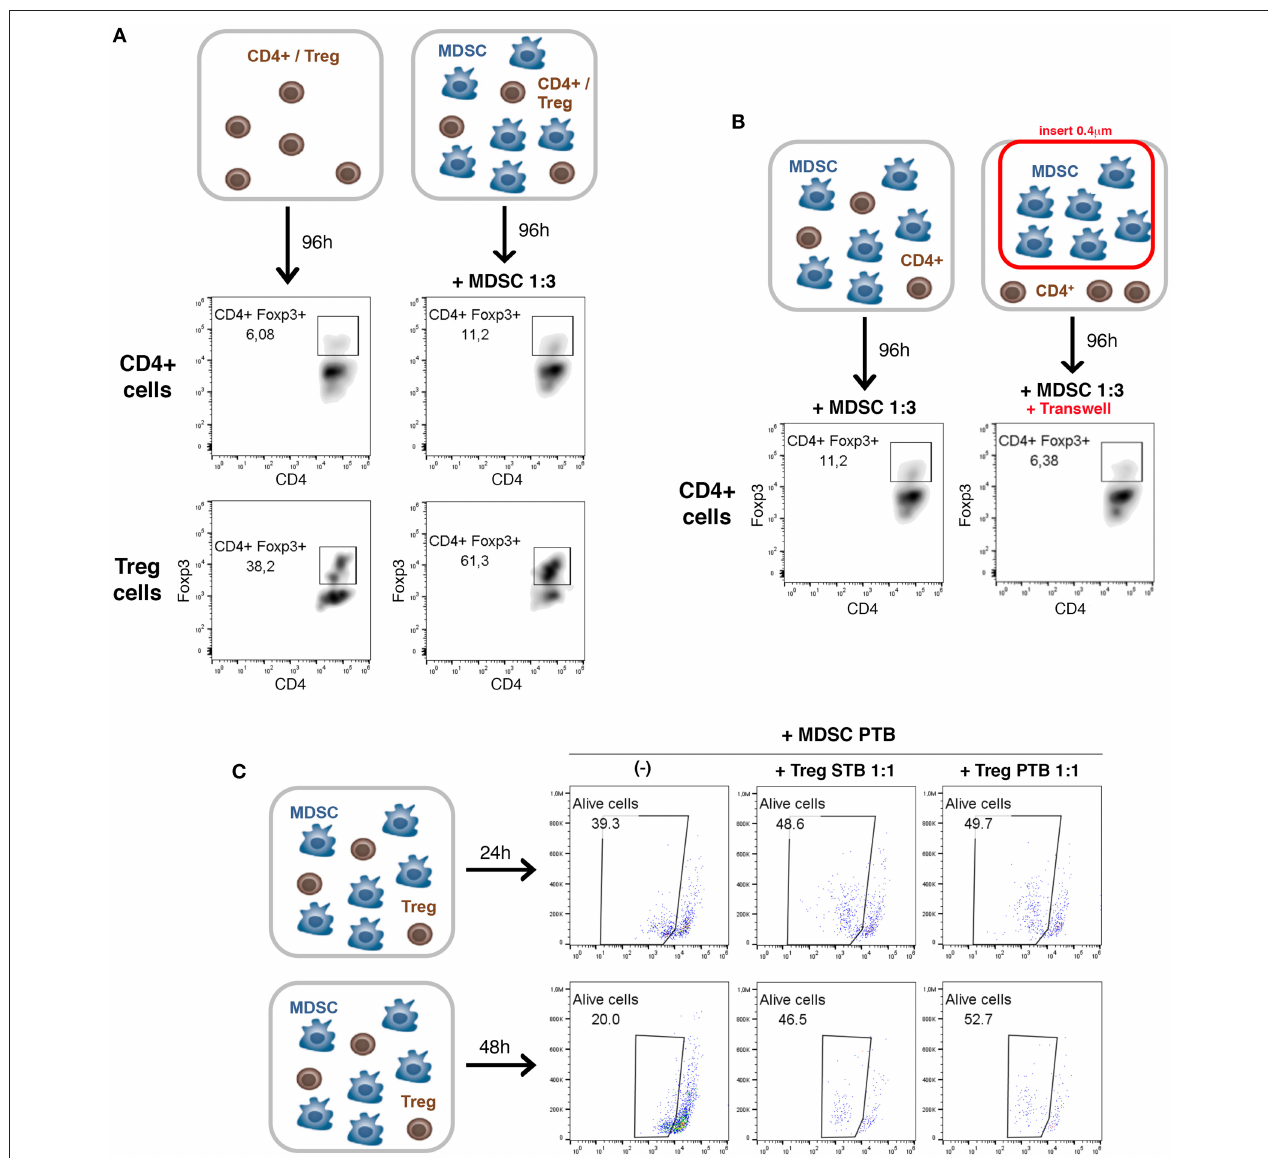
FIGURE 5 | A cell-cell dependent crosstalk between tumoral MDSCs and Treg cells. (A) Purified CD4 + T cells or Treg cells (CD4 + CD25 + ) from TB mice were cocultured with tumoral MDSCs. The percentage of CD4 + Foxp3 + cells was evaluated by flow cytometry after 4 days of culture in the presence of CD3/CD28 stimulation. (B) Purified CD4 + T cells from TB mice were cocultured with tumoral MDSCs at 1:3 ratio in conventional dishes or using Transwell chamber to separate the 2 cell populations. The percentage of CD4 + Foxp3 + cells was evaluated after 4 days by flow cytometry. (C) Purified Treg cells (CD4 + CD25 + ) from spleen of tumor-bearing mice (Treg STB) or tumor (Treg PTB) were cocultured with tumoral MDSCs for 24 or 48h. The viability of MDSCs was then assessed by flow cytometry using LIVE / DEAD Fixable Aqua Dead